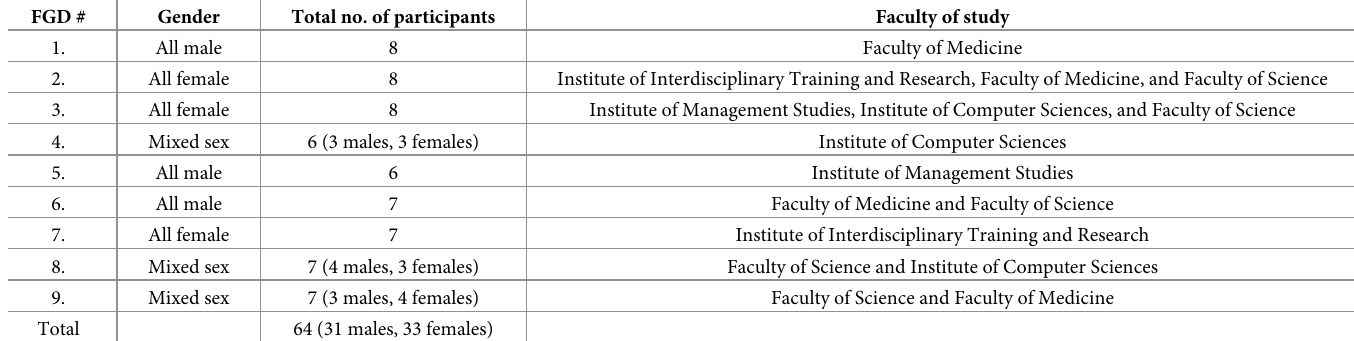
Table 1. Characteristics of focus group discussion (FGD)